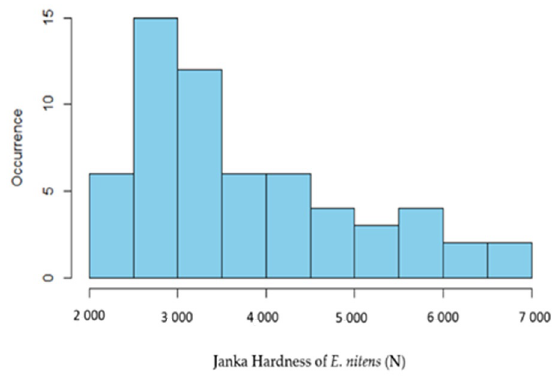
Figure 5. Distribution of Janka hardness results for sawlog E. nitens.